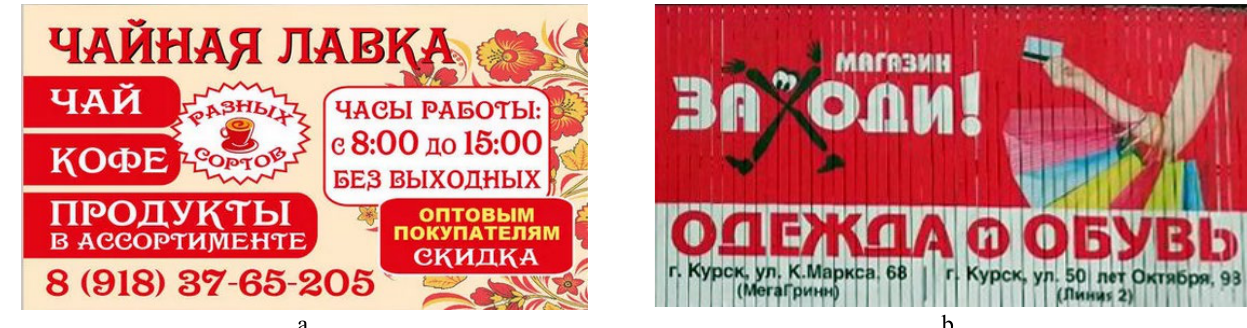
Figure 1 – Examples of commercial advertising